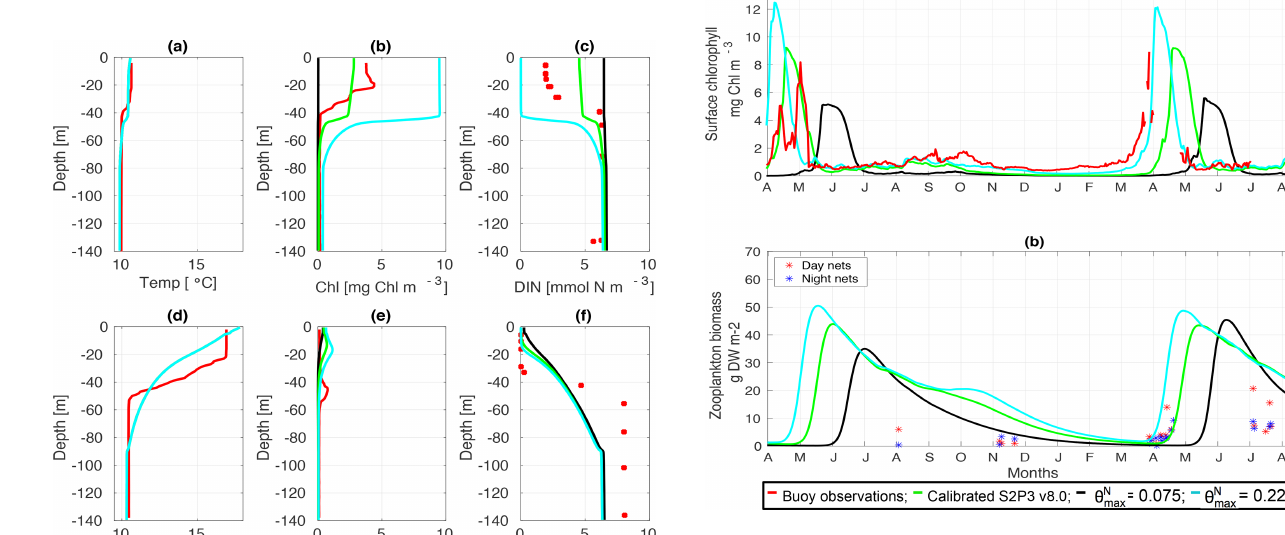
Figure C7. (a) SSB observations of surface chlorophyll a (red line), along with the modelled surface chlorophyll a for the calibrated S2P3 v8.0 model (green line), and experiments θ N max = 0 . 075 (black line) and θ N max = 0 . 225 (cyan line). (b) Observations of zooplank- ton biomass presented as discrete points for day nets (red dots) and night nets (blue dots) taken during the cruises DY026, DY018, DY029, and DY033; modelled zooplankton biomass from the cali- brated S2P3 v8.0 model (green line) and experiments θ N max = 0 . 075 (black line) and θ N max = 0 . 225 (cyan